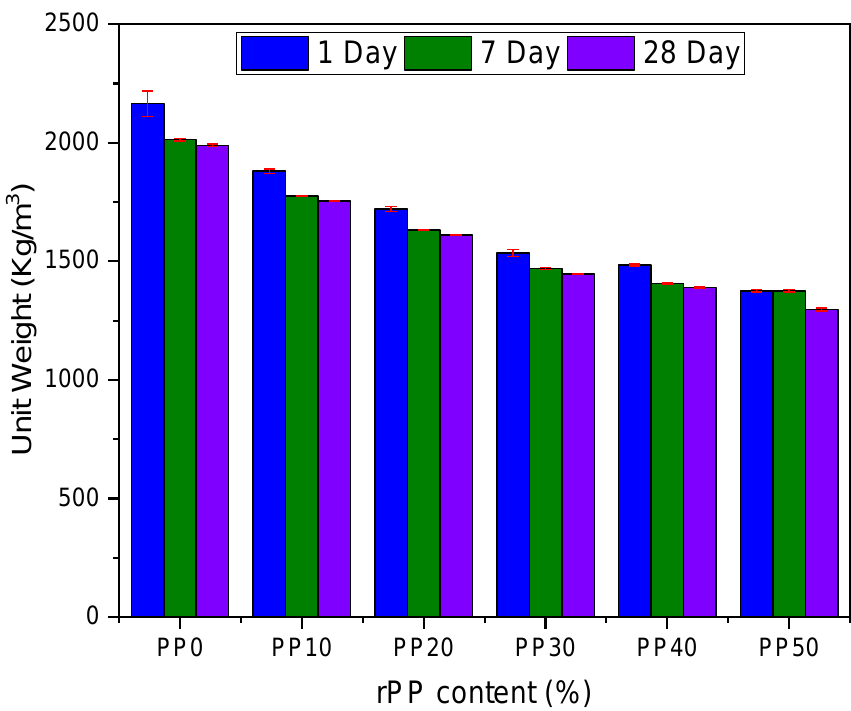
Figure 4. Effect of rPP addition on dry unit weight at different ages.